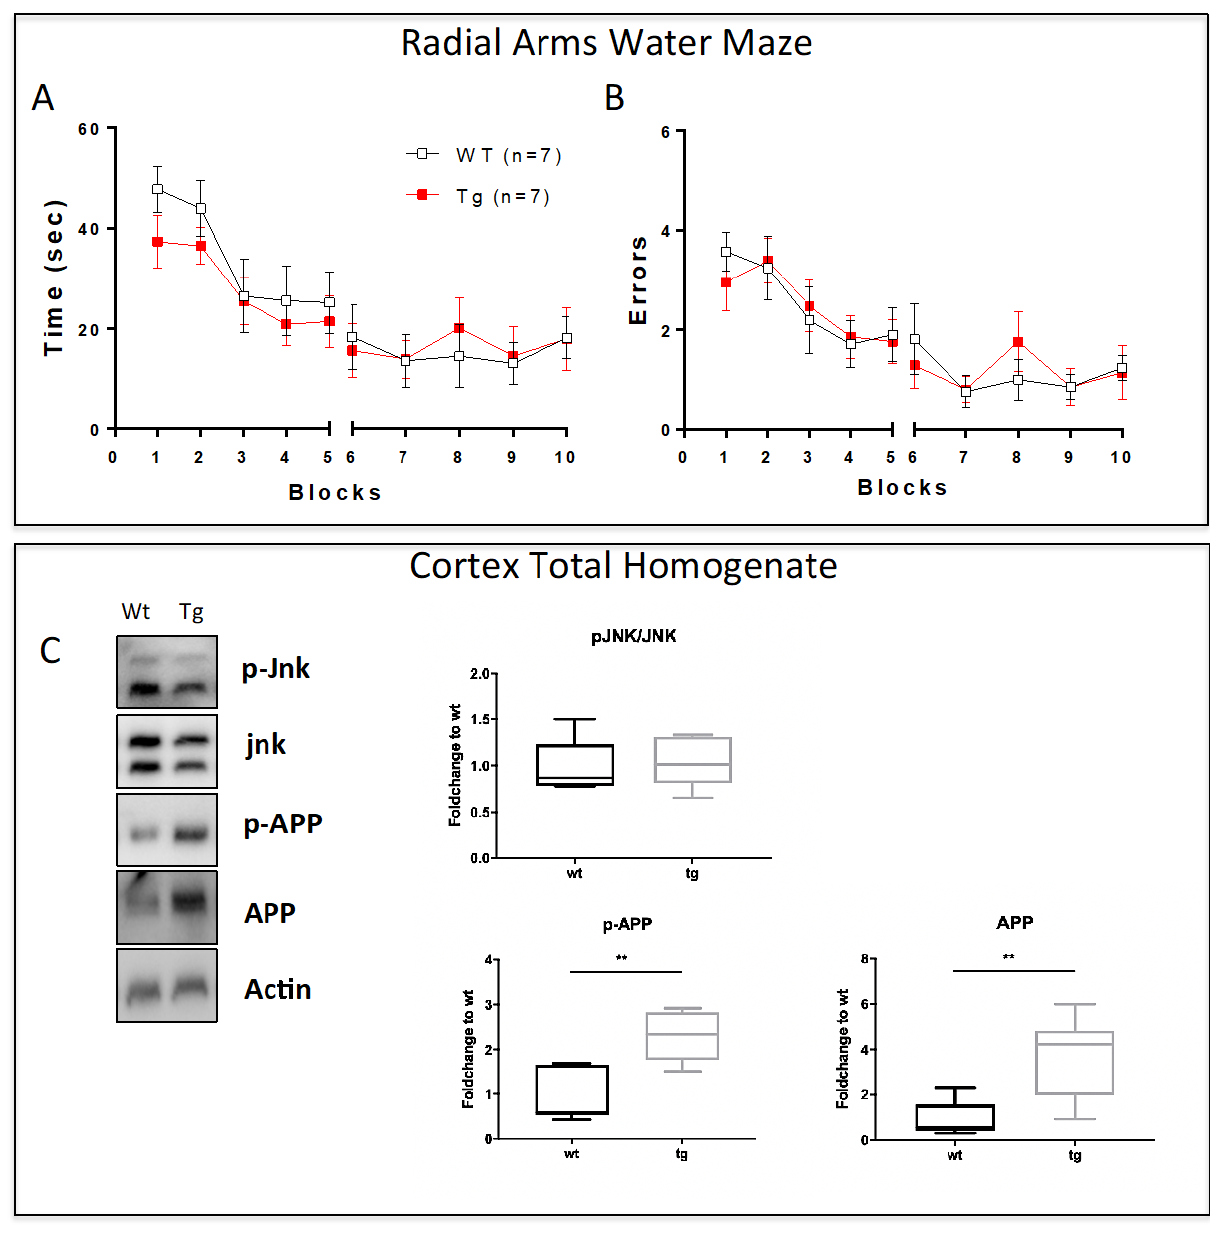
Figure 1. Absence of memory impairment and JNK activation in 2-month-old 5xFAD mice. ( A ) Time and ( B ) number of errors to find the submerged escape platform demonstrate the absence of cognitive impairment in 2-month-old 5xFAD mice. ( C ) Representative Western blots and relative quantifications of cortical total homogenate show higher levels of p-APP, APP, and no differences in p-JNK/JNK ratio in 5xFAD vs. wt mice. Genotypes are compared using t -tests. Statistical significance: ** p < 0.01. Data are expressed as mean ± SEM.